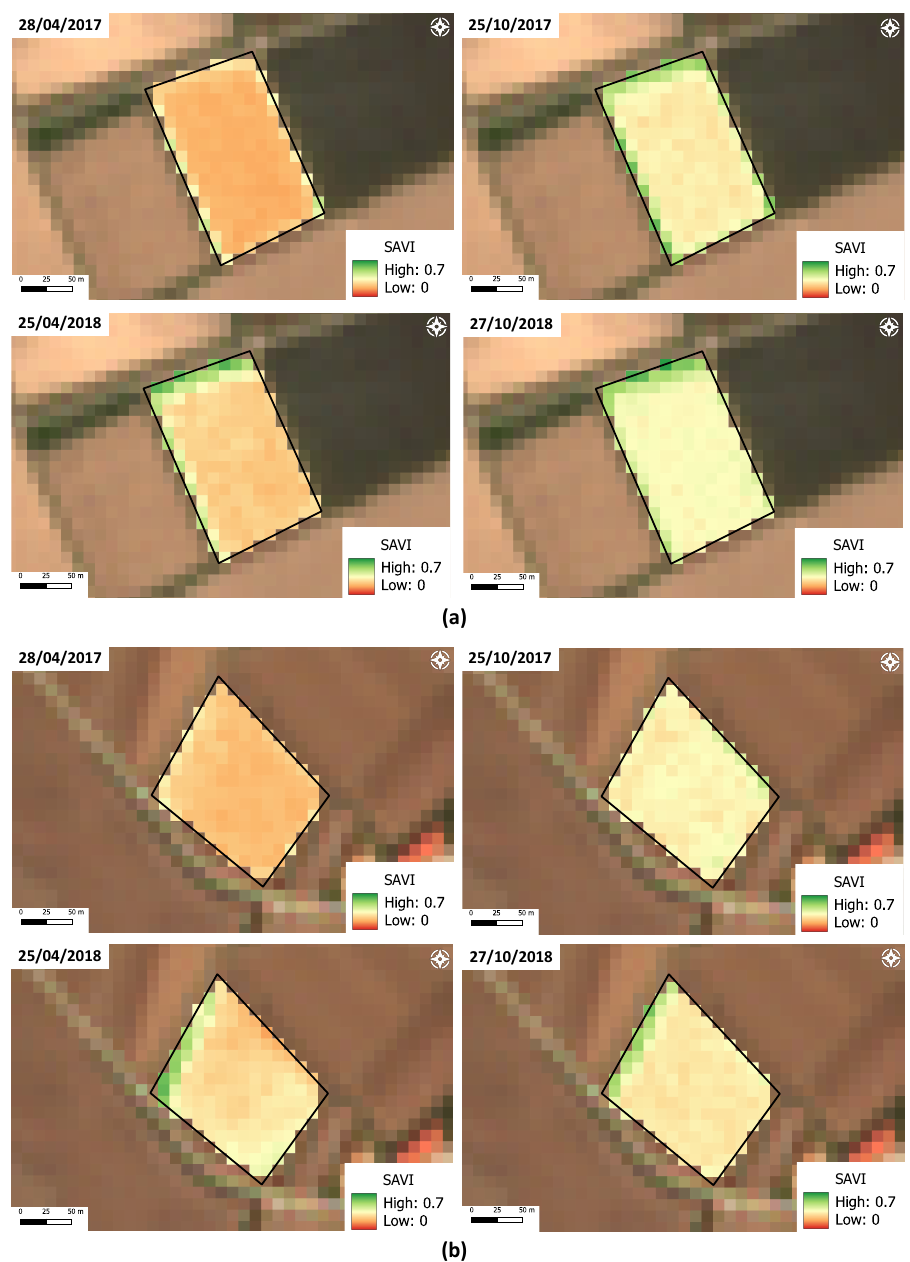
Figure 6. Spatial distribution of SAVI in the selected field plots: ( a ) Quinta do Canal and ( b ) Pranto. The samples are from the Spring and Autumn of 2017 (top panels) and 2018 (bottom panels), before and after the rice crop cultivation period.